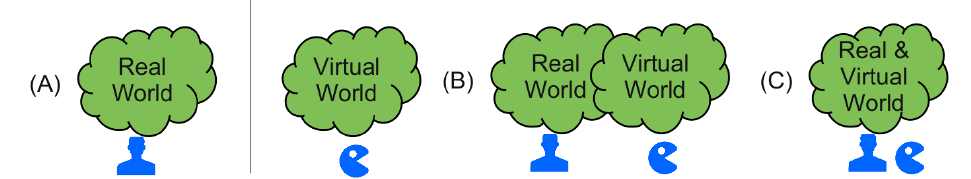
Figure 3. ( A ) Real-world only deployed with humans. ( B ) non-overlapping real and virtual world, and ( C ) overlapping real and virtual world .